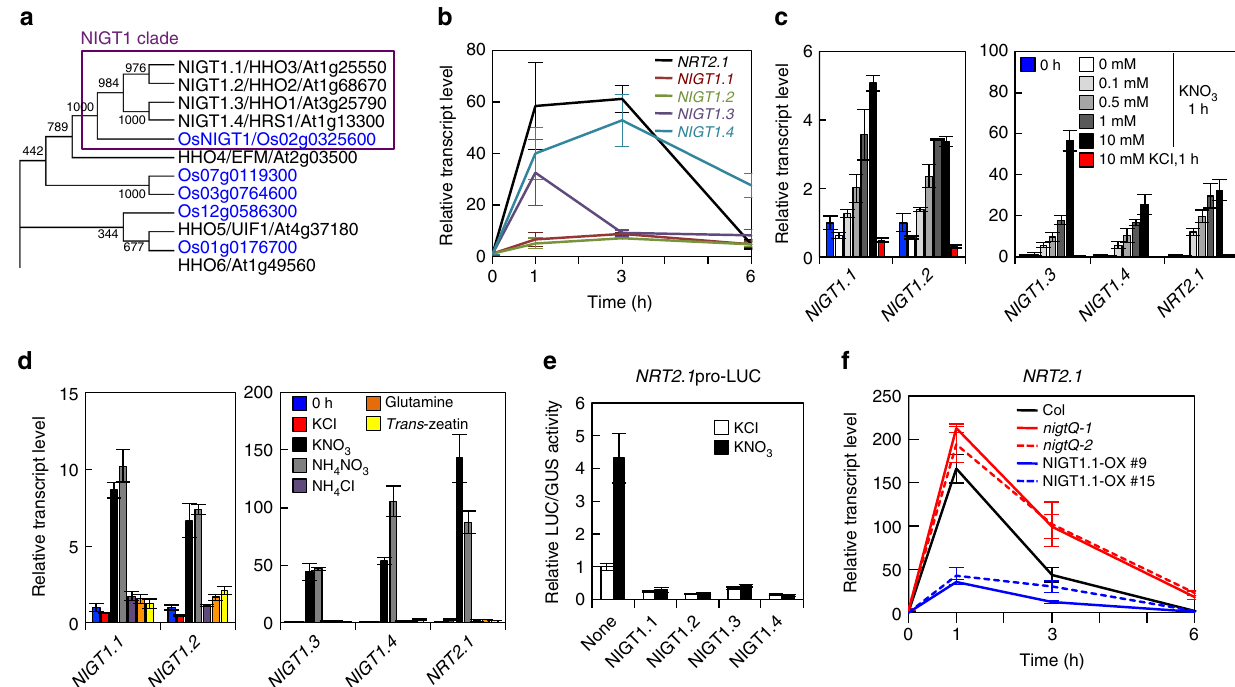
Fig. 2 NIGT1 proteins redundantly regulate NRT2 . 1 expression. a Phylogenic analysis of Arabidopsis and rice NIGT1/HHO proteins. Arabidopsis and rice proteins are shown in black and blue, respectively. Numbers indicate bootstrap values of 1000 iterations. b Time-dependent expression patterns of NIGT1- clade genes after 10 mM KNO 3 supply. c Concentration-dependent induction by nitrate. RNA was prepared from ammonium-grown seedlings before treatment and after treatment with 0, 0.1, 0.5, 1 and 10 mM KNO 3 for 1 h. A 10 mM KCl treatment was used as a control. d Nitrate-speci fi c induction of NIGT1 - clade genes. Ammonium-grown seedlings were treated for 1 h with 10 mM of each chemical, except for trans- zeatin (5 µ M). e Repression of the NRT2 . 1 promoter by NIGT1 proteins. Protoplasts co-transfected with NIGT1 expression vectors or the empty vector (none) together with the reporter plasmid containing the LUC gene under the control of the NRT2 . 1 promoter were incubated in the presence of 1 mM KCl or KNO 3 . LUC activity was normalised to GUS activity from the co-transfected UBQ10-GUS plasmid. Data are means± s.d. of three biological replicates. f Transcript levels of NRT2 . 1 in the nigt1 quadruple mutants ( Q-1 and Q-2 ) and NIGT1.1-OX plants after 10 mM KNO 3 supply. Values are normalised to those of UBQ10 , and are means of biological triplicates ± s.d. ( b , c , d , f